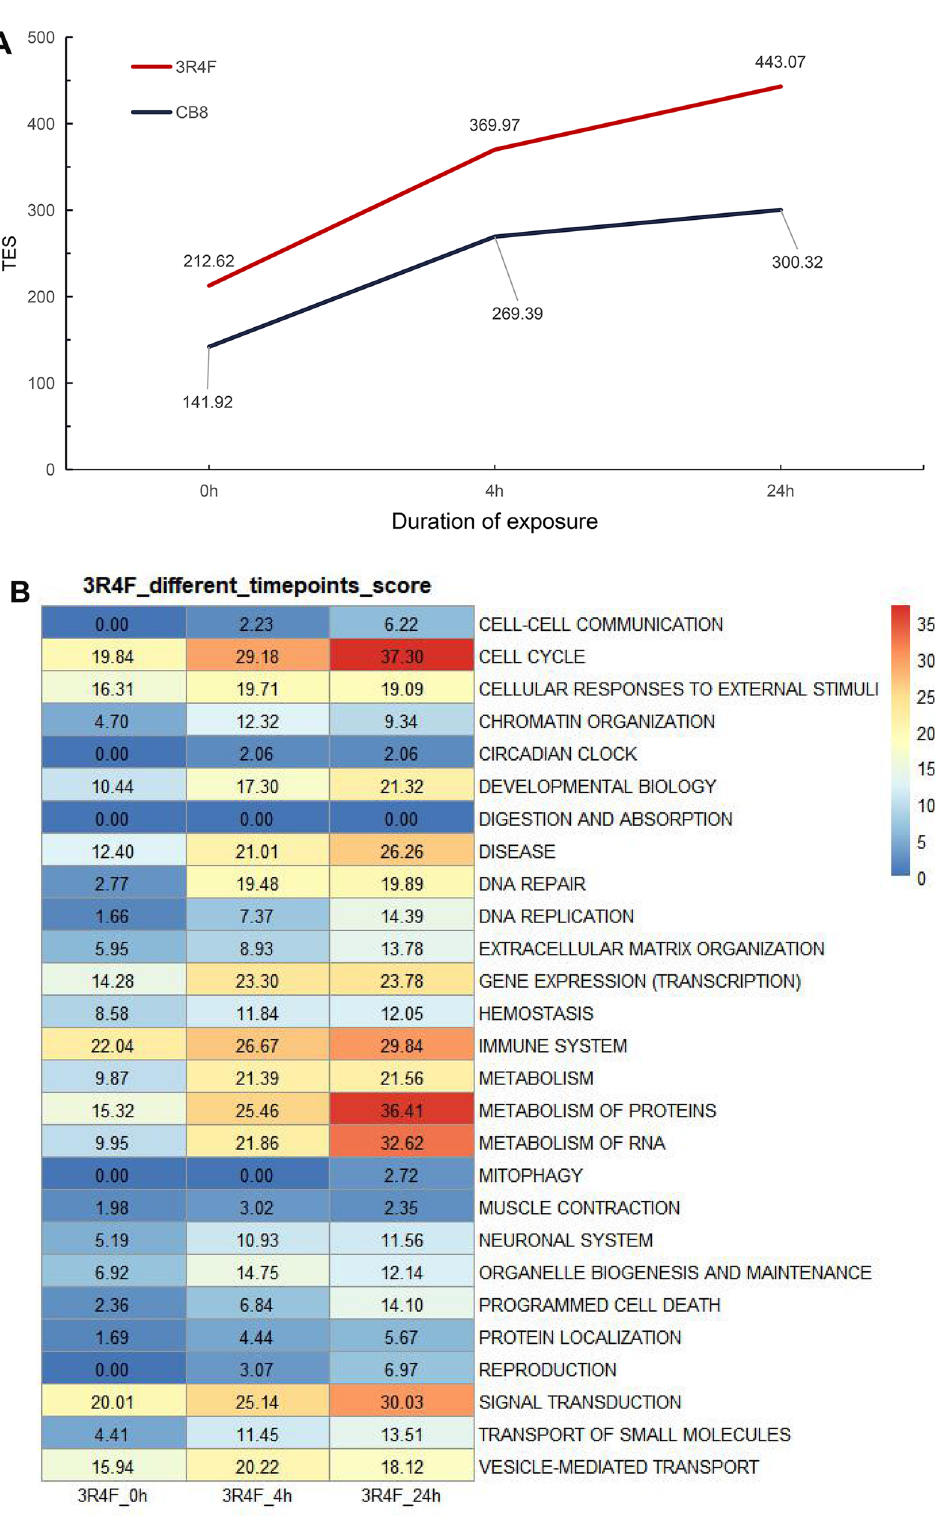
Figure 5. Application of the SPPA algorithm in comparisons of the biological impact of MS from reference versus commercial cigarettes. A The total effect scores (TES) for three time points after reference 3R4F and commercial CB8 smoke exposure using SPPA algorithm. B , C The degree of effect of 3R4F ( B ) and CB8 ( C ) smoke exposure on 27 cell-related topics at different time points. The redder the color, the higher the effect score. D The Z-score values of ten cancer-related pathways at different time points under 3R4F and CB8 treatment using SPPA algorithm. The larger the sector area, the larger the Z-score value, indicating the greater the perturbation to the